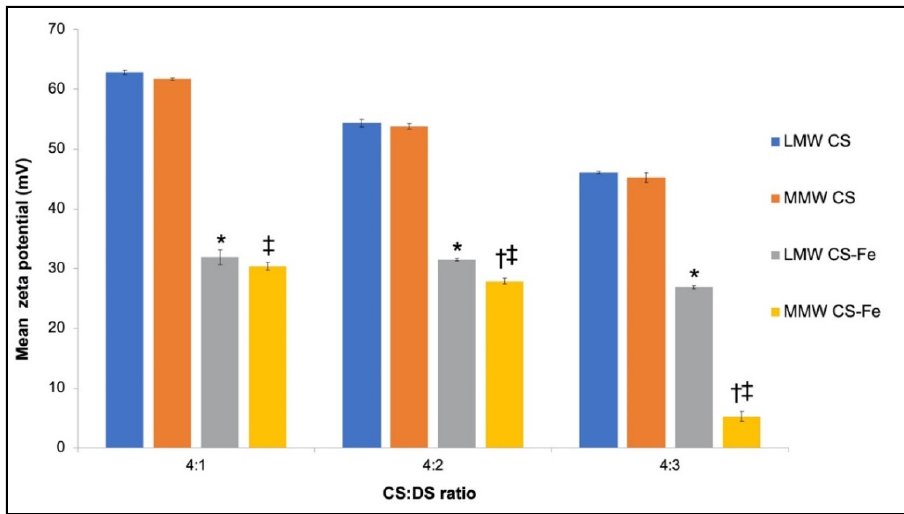
Figure 5. Zeta potential of iron-entrapped CS-DS nanoparticles when using different MWs of chitosan at various CS:DS ratios. Results are shown as mean ± SD (n = 3). Data were considered statistically different when p < 0.05. * indicates a significant difference between LMW CS and LMW CS-Fe at the same ratio, † indicates a significant difference between LMW and MMW CS-Fe at the same ratio, ‡ indicates a significant difference between MMW CS and MMW CS-Fe at the same ratio.